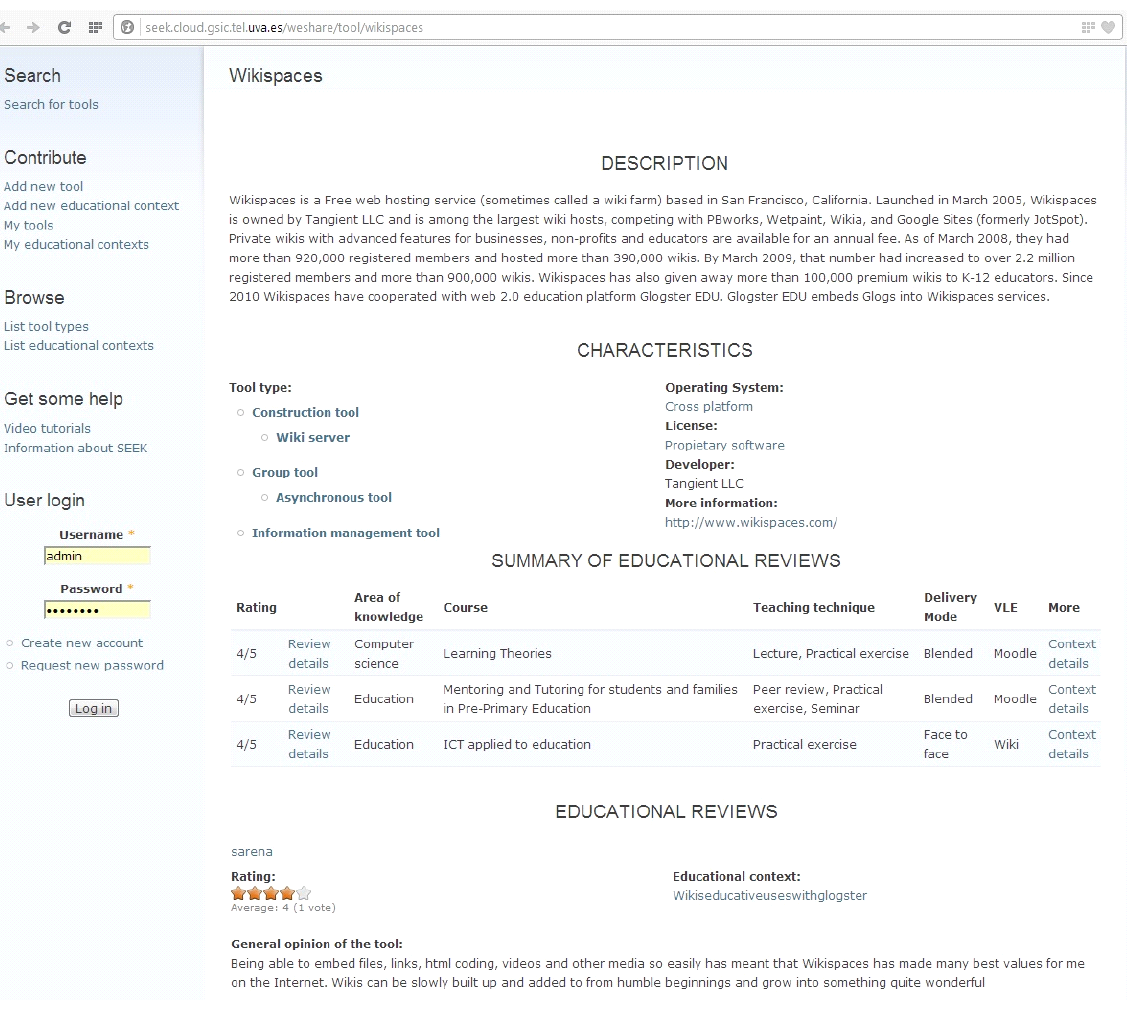
Figure 4. Snapshot of the browsing interface of We-Share showing part of the description of Wikispaces (the tasks supported and the artifacts managed by the tool were removed from